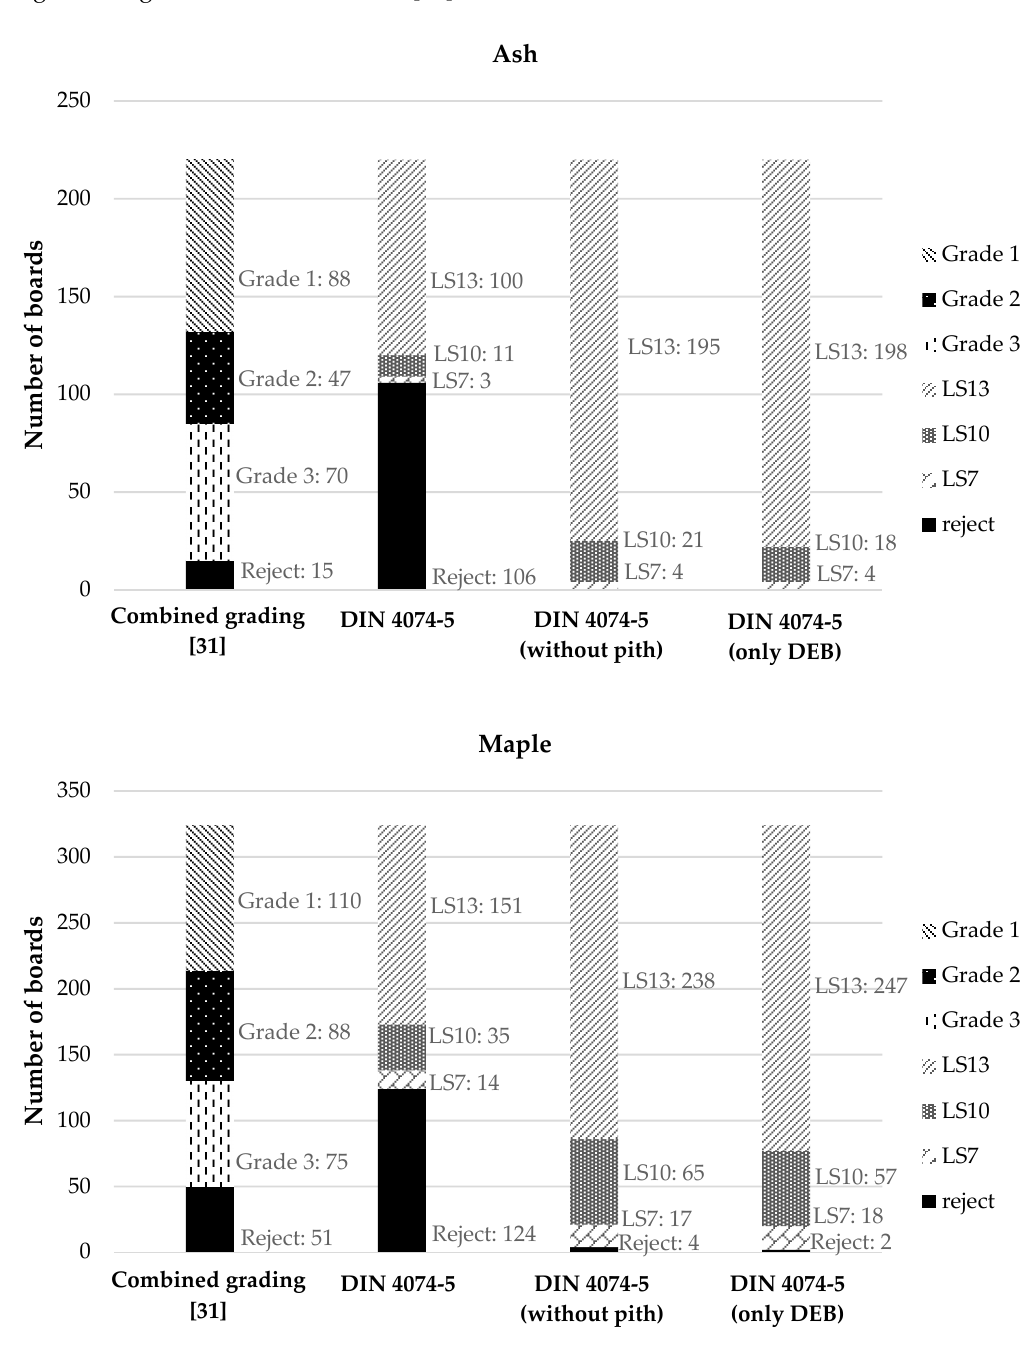
Figure 3. Yields for the combined (left bar) and visual grading (three right bars) of the planed ash and maple boards.